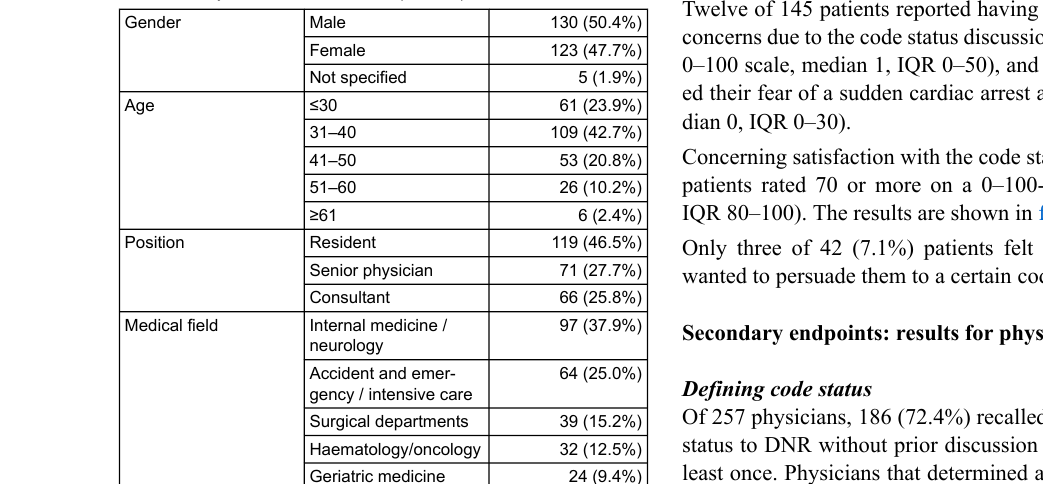
Table 1b: Physicians’ characteristics (n =